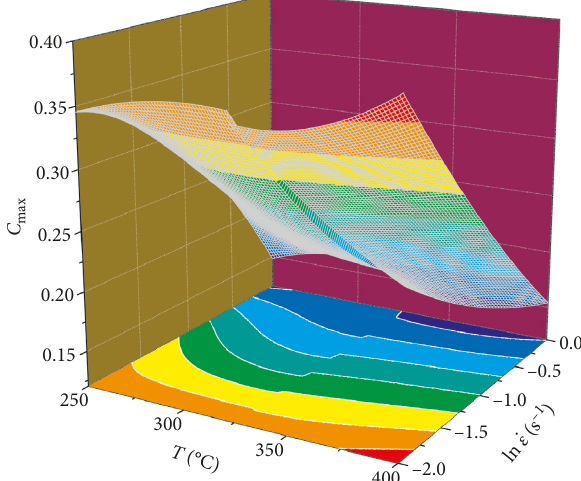
Figure 8: Temperature and strain rate effect on the critical damage value of AZ31 magnesium